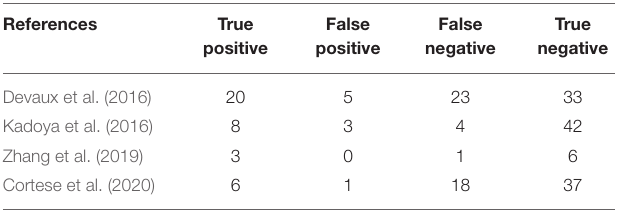
TABLE 7 | Two-by two contingency table for diagnosis of a subtype of CIDP characterized by poor response to IVIg using anti-NF155